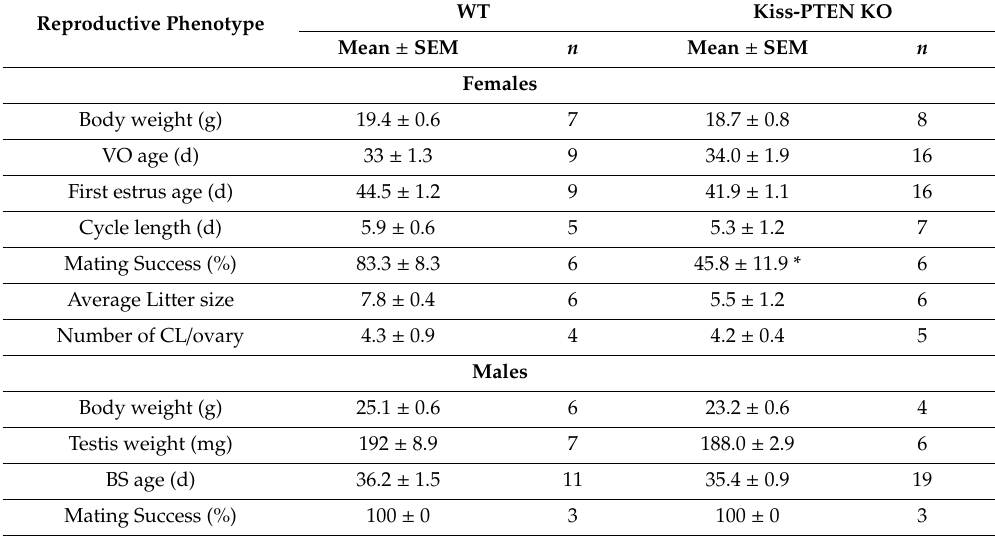
Table 1. Reproductive physiology data grouped by genotype and